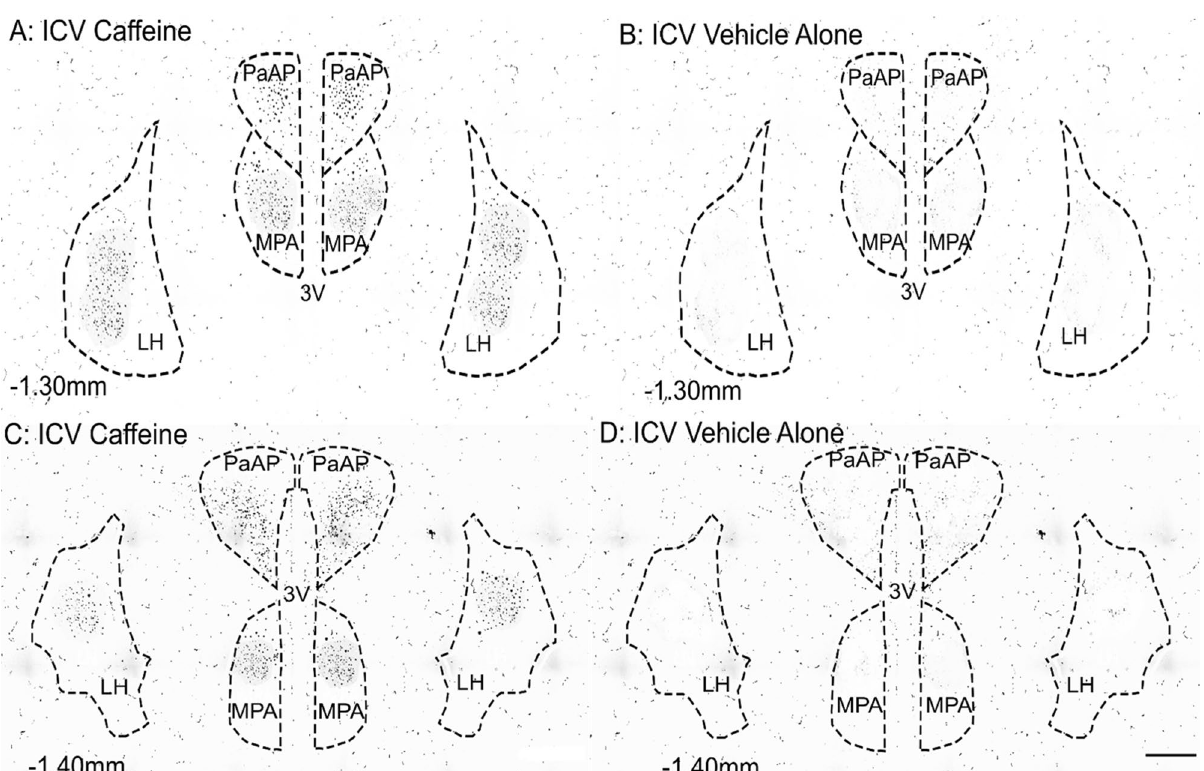
Figure 4. Photomicrographs illustrating the rostrocaudal levels of the paraventricular hypothalamic nucleus anterior parvo (PaAP), medial preoptic area (MPA), lateral hypothalamus (LH) delineation of regions by immunostaining of cFos ir (dark speckled puncta on image): ( A ) − 1.30 mm bregma of caffeine treated rats; ( B ) − 1.30 mm bregma of vehicle treated rats; ( C ) represent -1.40 mm of caffeine treated rats; ( D ) − 1.40 mm bregma of vehicle treated rats. Dashed lines represent regions of interest. 3 V 3rd ventricle. Scale bar, 200